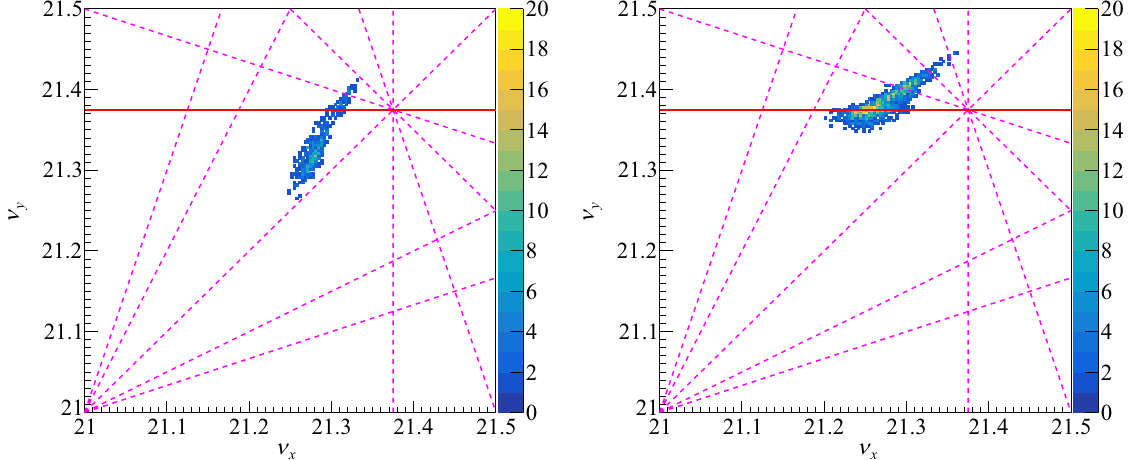
FIG. 4. Simulated tune distributions of the lost particles with J x > J y (left) and J x < J y (right) in the MR with the present FX optics. The tunes were calculated with one turn phase advance before the loss. The red solid lines represent the resonance 8 ν y ¼ 171 , and the magenta dashed lines represent other space charge resonances up to the eighth